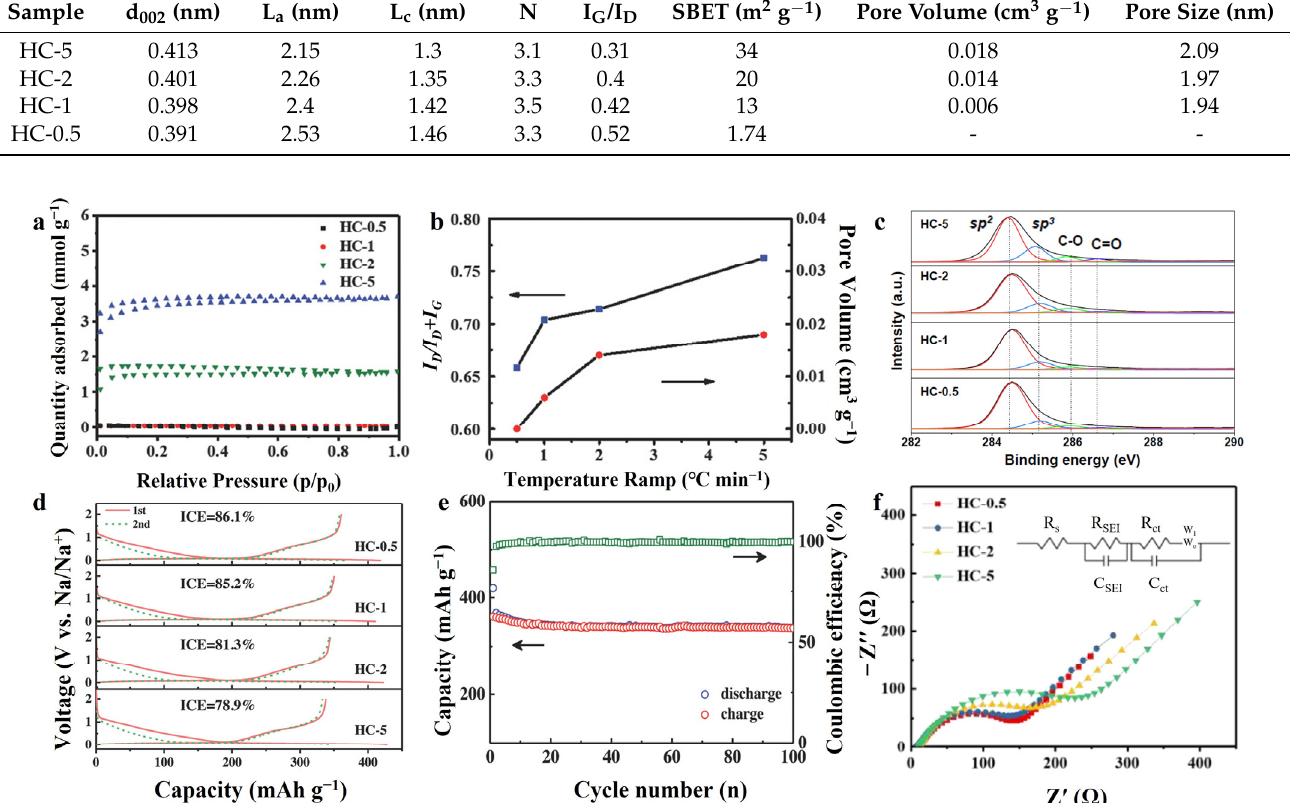
Figure 6. ( a ) N 2 adsorption–desorption isotherms, ( b ) I D /I D + I G and speci fi c pore volume, ( c ) XPS C 1s spectra. ( d ) The fi rst discharge–charge pro fi les and ( e ) cycling performance for HC-0.5